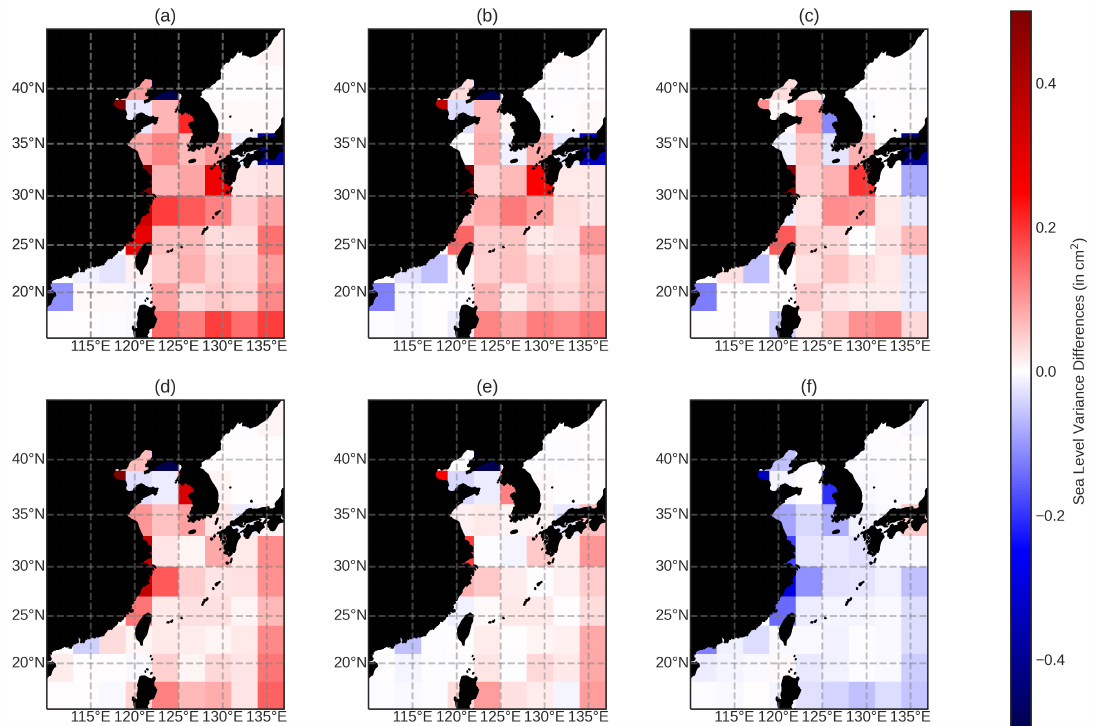
Figure 7. The same as in Figure 5, but for the Yellow Sea